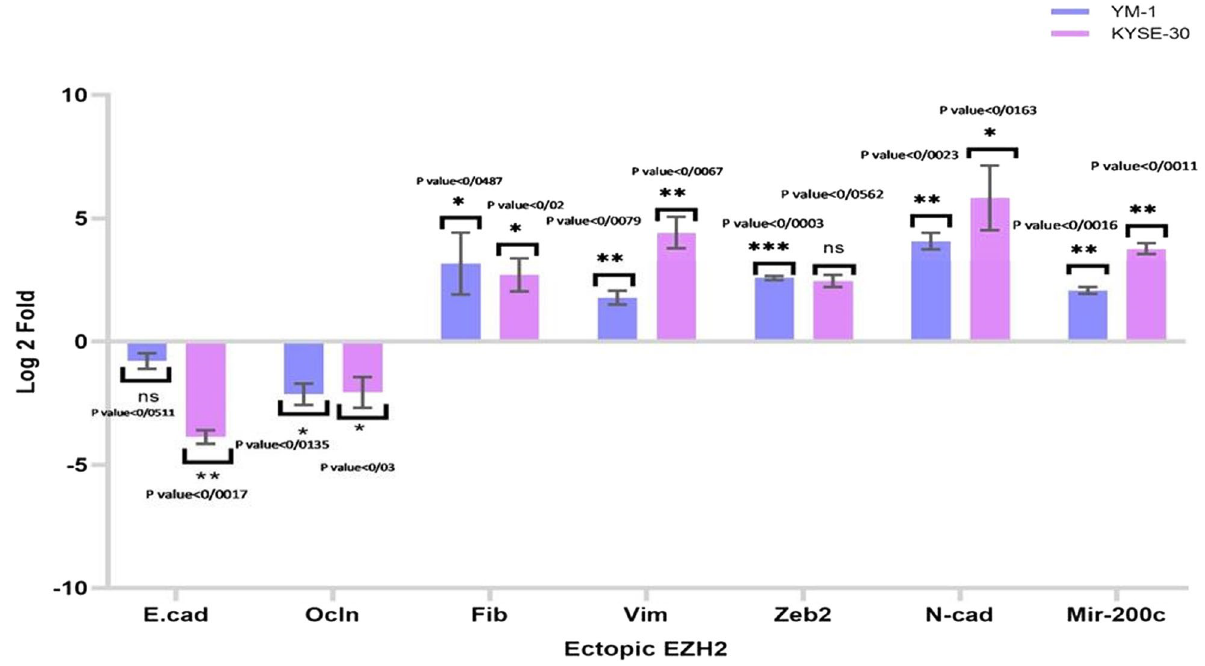
Figure 4. In our study demonstrated that Eectopic expression of EZH2 in ESCC lines upregulates Mir-200c and mesenchymal genes expression while down-regulates expression of epithelial gene. EZH2-overexpressing cell lines YM-1 and KYSE-30 overexpressed miR-200c nearly 2.07 and 3.81-folds compared to control cells, as well as an increase in ZEB2, Fibronectin, N-cadherin and Vimentin mRNA levels, and a decrease in the level of the epithelial gene expression (E-Cadherin and Occludin). The use of an asterisk (*) denotes statistical significance.